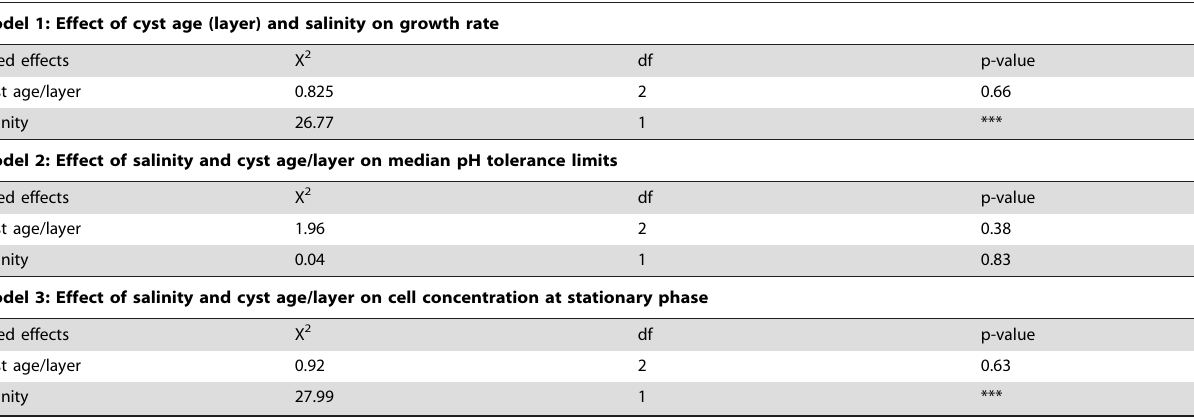
Table 2. Summary statistics for the applied Linear Mixed Effects Models (LMEM) of growth rate, median pH tolerance limits, and cell concentration at stationary phase as functions of cyst age/sediment core layer and salinity (fixed effects) with strain as a random